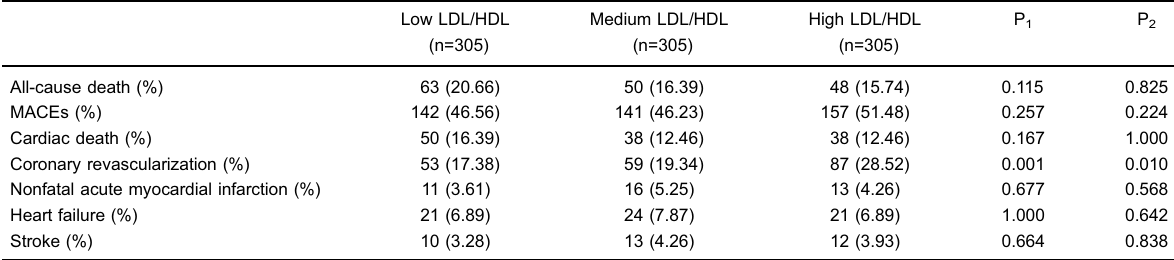
Table 2. Comparison of all-cause death, MACEs, and coronary revascularization among the three groups.